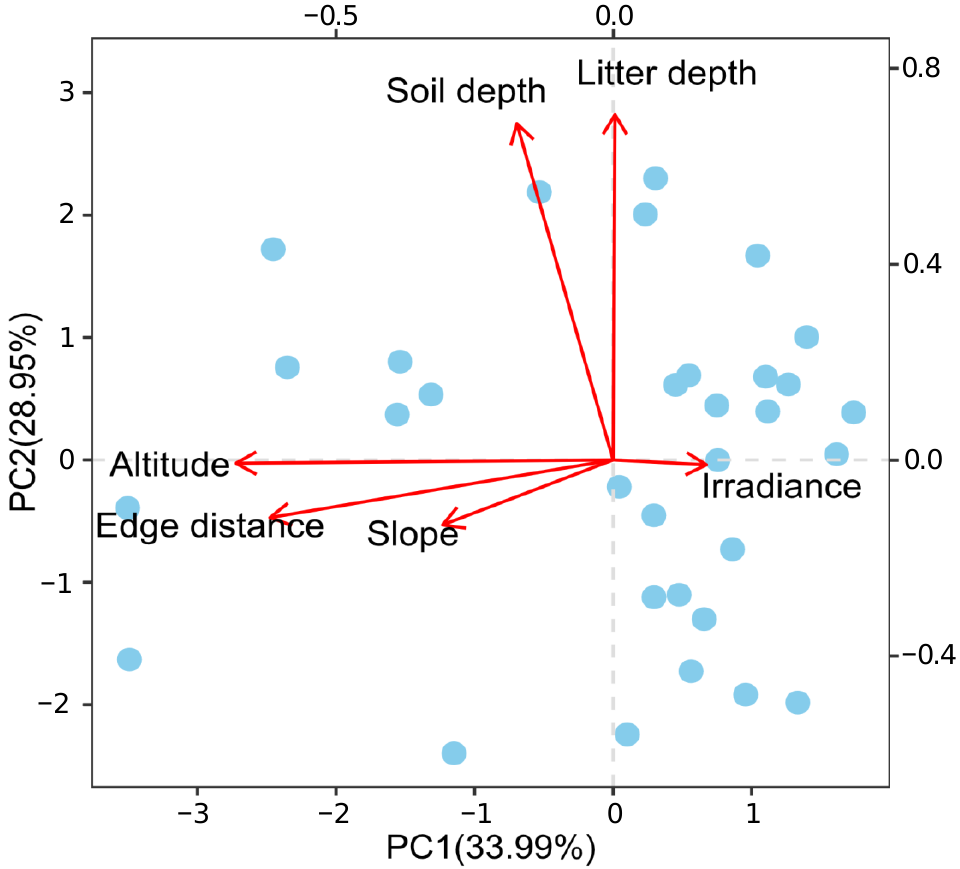
Figure 4. Principal component analysis (PCA) for six environmental factors.